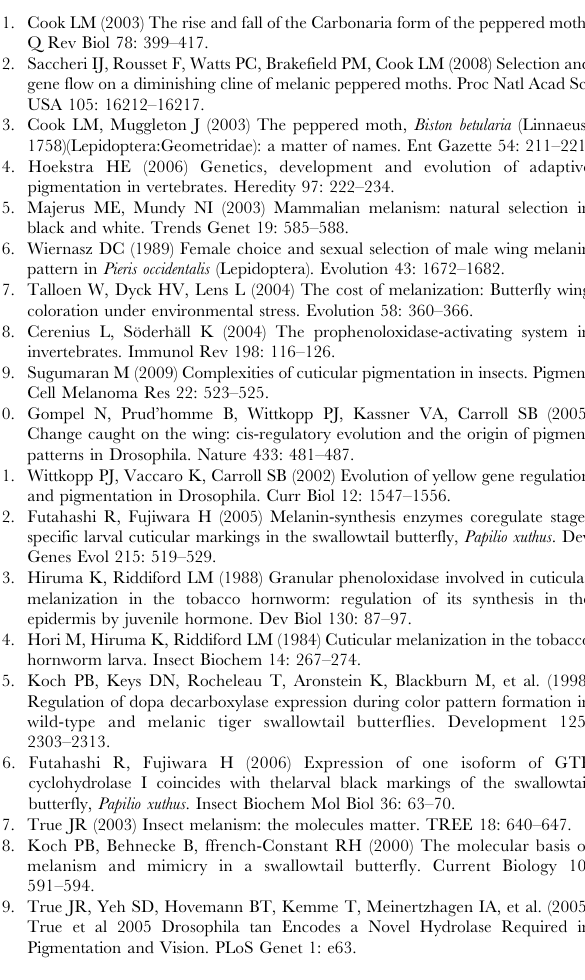
Table S2 Table of primers used to isolate and genotype the candidate